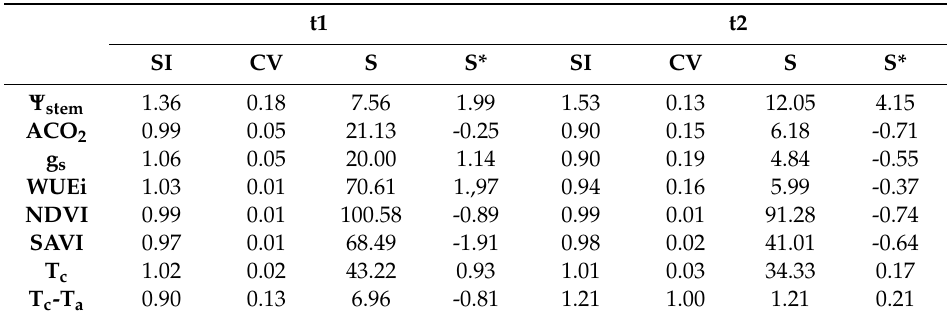
Table 2. Sensitivity analysis for terrestrial and remote plant water status indicators at the two flight times: t1 (10:00 GMT) and t2 (12:00 GMT).